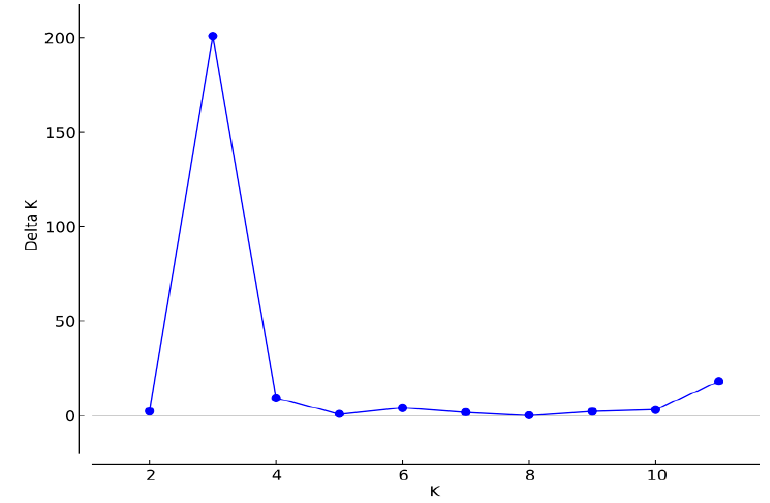
Figure 2. Values of ∆ K , with its modal value detecting a true K of three groups ( K = 3).